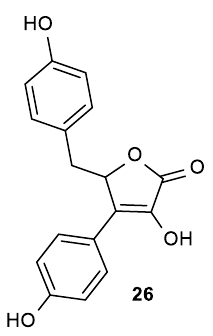
Figure 10. The lipophilic aromatic butenolide derivative 26 . Table 6. Antioxidant activity of the aromatic butenolide 26 . Comp.